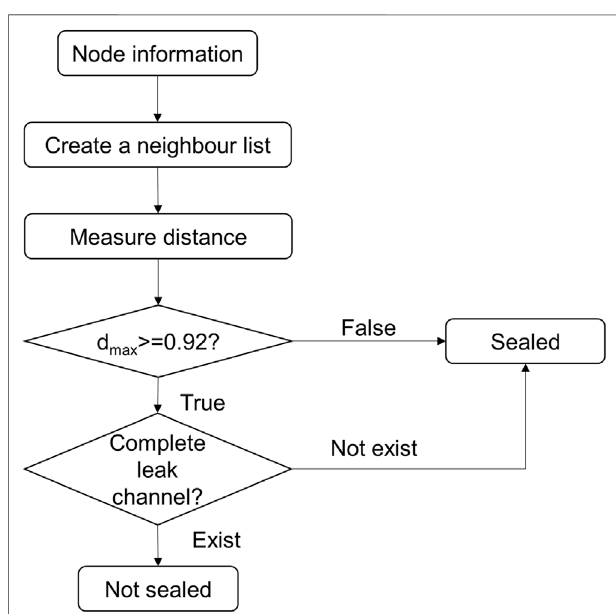
FIGURE 7 | Flow chart of the detection technique.